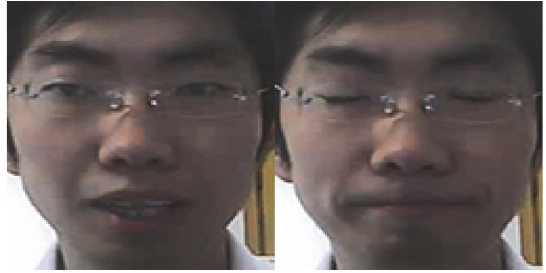
Figure 4: Real face extract from the video streaming